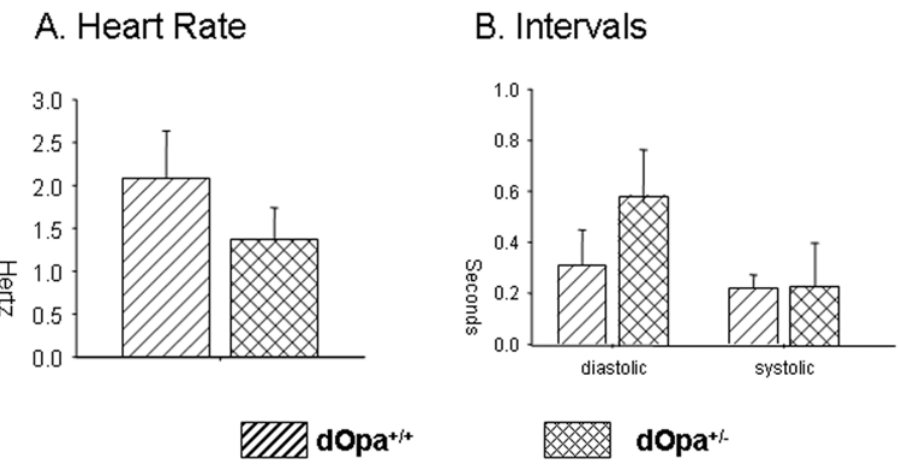
Figure 5. A. Heterozygous mutation of dOpa1 results in decreased heart rate (p , 0.001). Single dashed bars represent dOpa1 + / + and double dashed bars represent dOpa1 + / 2 Drosophila . Error bars are standard deviation of the mean. Heart rates were recorded at 3 weeks of age. Figure 5B. The decreased heart rate shown in Figure 5A was predominantly due to an increase in diastolic intervals ( , 0.001), not an increase in systolic intervals (0.09).